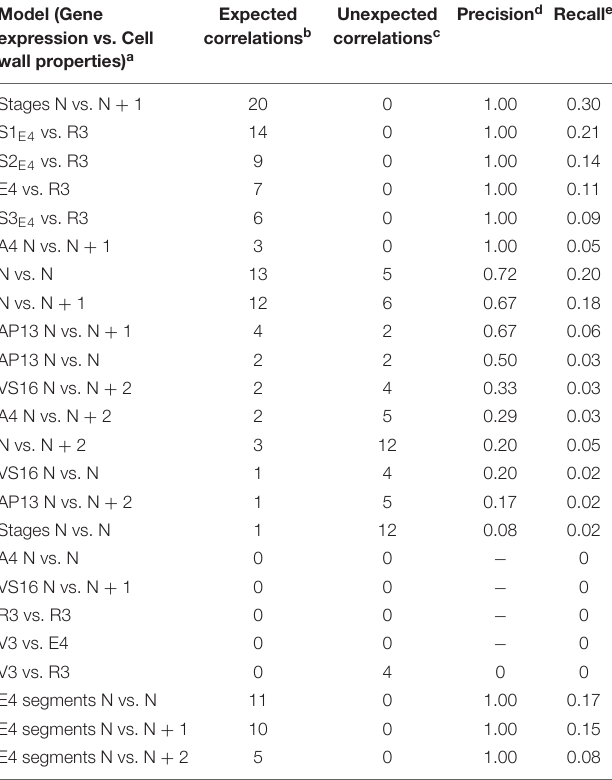
TABLE 3 | Significant correlations between switchgrass phenylpropanoid biosynthesis gene expression and cell wall properties for various data subsets and relationships, i.e.,